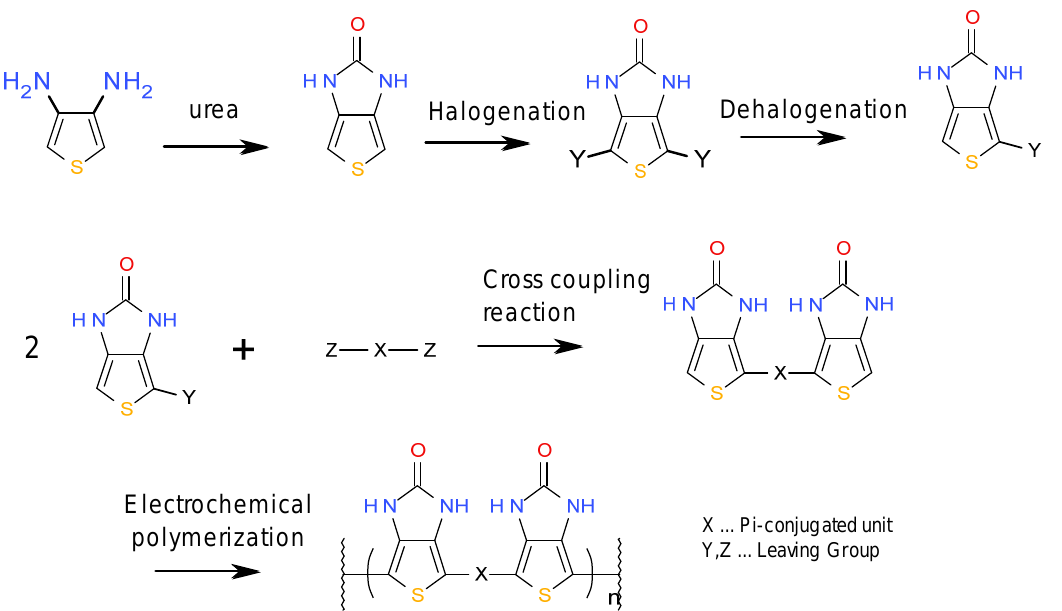
Figure 5. The preparation scheme of our EC